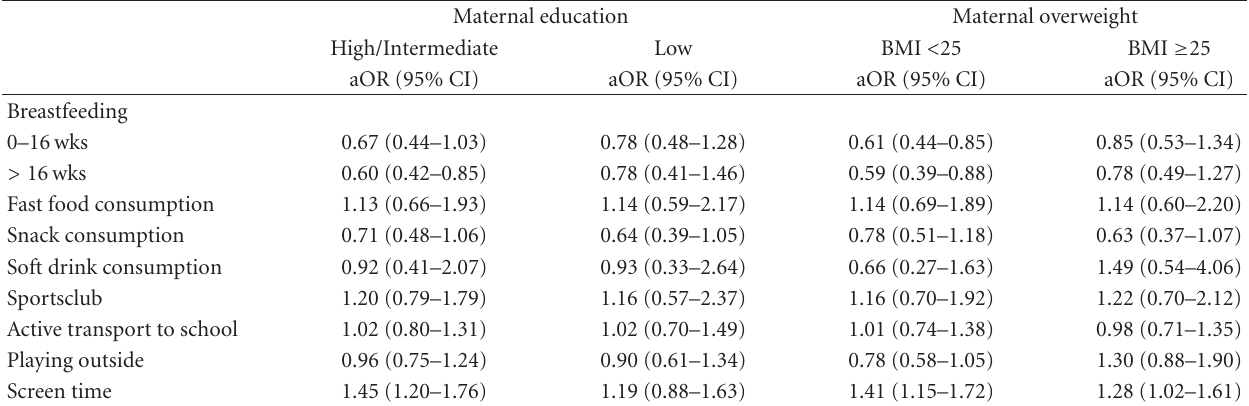
Table 4: Adjusted 1 odds ratios (95% CI) for the associations of behavioral risk factors with overweight (incl. obesity) at the age of 8 years, stratified by maternal education and by maternal